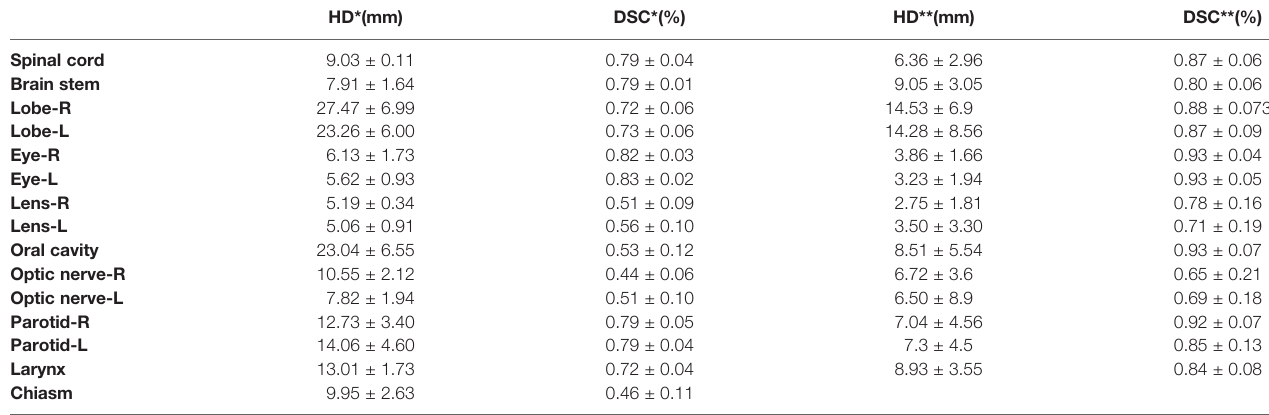
TABLE 1 | The DSC and HD values of 2 evaluation parameters for the 15 OARs segmentation.